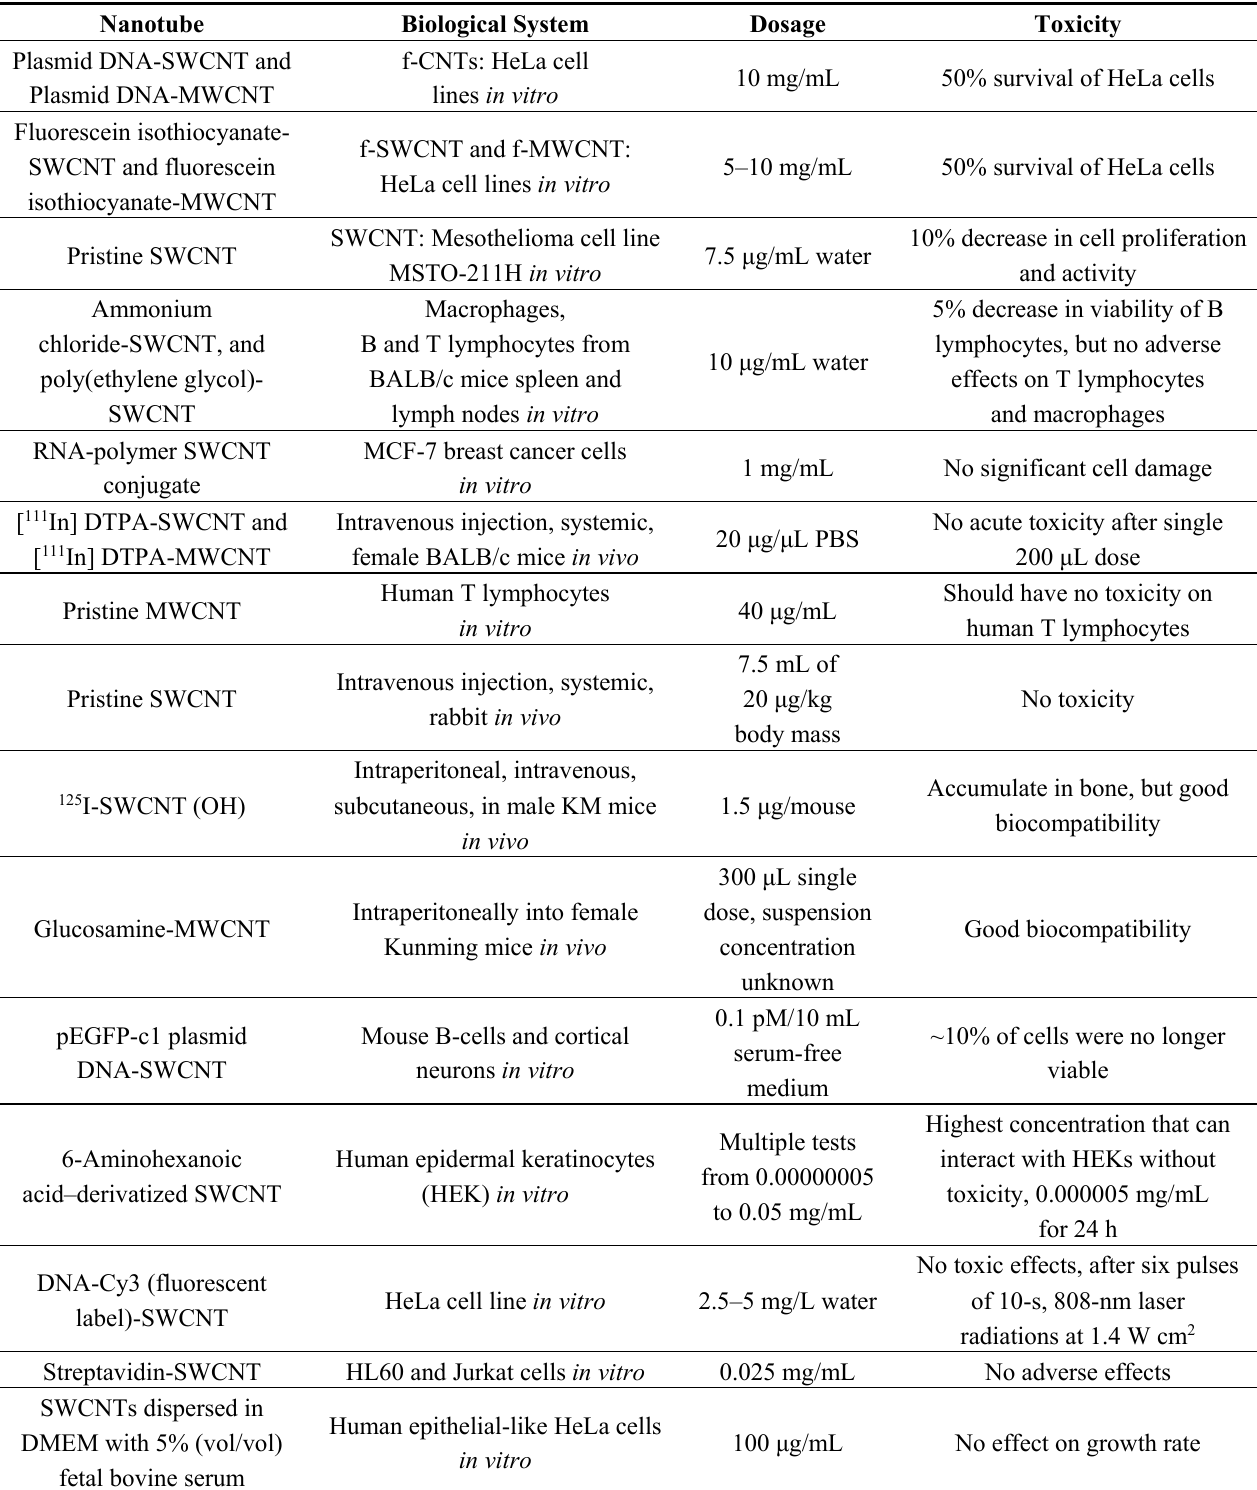
Table 1. A compilation of cellular and tissue toxicity studies of pristine or functionalized carbon nanotropes